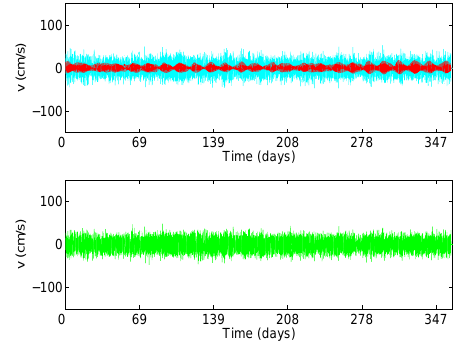
Fig. 1. Linearly interpolated raw data (black), low-passed data (blue) and high frequency data (cyan) are shown for v component at location FB, 524m depth.